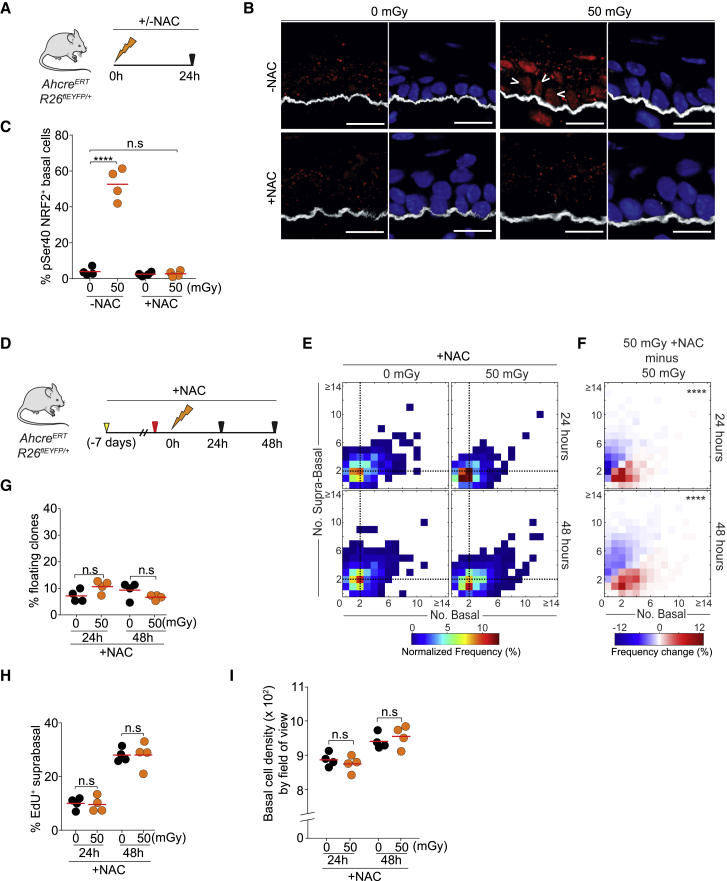
Antioxidant Treatment Abolishes NRF2 Nuclear Translocation and Radiation-Induced Differentiation In Vivo(A) Experimental protocol. YFP reporter mice were exposed to 0 or 50 mGy of LDIR with or without NAC treatment, and EE samples were taken 24 h later.(B) NRF2 (phospho-serine40) staining (red) in optimal cutting temperature compound (OCT)-embedded, 10-μm-thick cryosections of EE of Cyp1A1creERTRosa26flEYFP/WT from (A). Arrowheads show basal cell nuclei positive for NRF2. Also shown are the basement membrane marker ITGA6 (white) and DAPI (blue). Scale bars, 14 μm.(C) Quantification of pSer40 NRF2+ basal cells shown in (B). Points are mean values from individual mice. ∗∗∗∗p < 0.0001; n.s., not significant (unpaired t test); n = 4 mice.(D) Experimental protocol. YFP reporter mice were given the oral antioxidant N-acetyl cysteine (NAC) 7 days after cell labeling with YFP (yellow arrow) and throughout the experiment, and EdU was injected 1 h prior to LDIR (red arrow). Clone sizes were analyzed 24 and 48 h after irradiation.(E) Heatmaps showing the frequency of clones containing a number of basal and suprabasal cells observed in 50 mGy versus 0 mGy irradiated animals under NAC treatment. Black dots and dashed lines show geometric median clone size.(F) Frequency of changes observed in 50 mGy NAC-treated versus 50 mGy non-treated animals. ∗∗∗∗p < 0.0001 (Peacock’s test), n = 600 clones per condition.(G–I) Percentage of floating clones (G), percentage of EdU+ suprabasal cells (H), and basal cell density (I) 24 h and 48 h after 0 or 50 mGy LDIR. Points are mean values from individual mice. n.s., p > 0.05 by unpaired t test; n = 4 mice per condition.See also Tables S2 and S4.